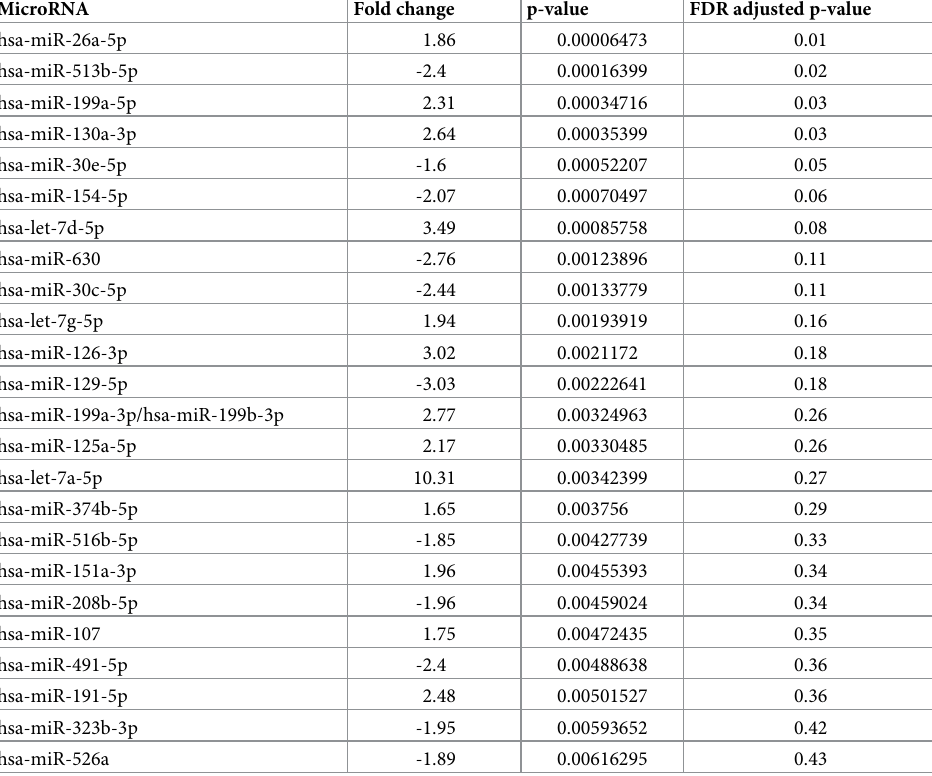
Table 3. Top 25 differentially expressed miRNAs.